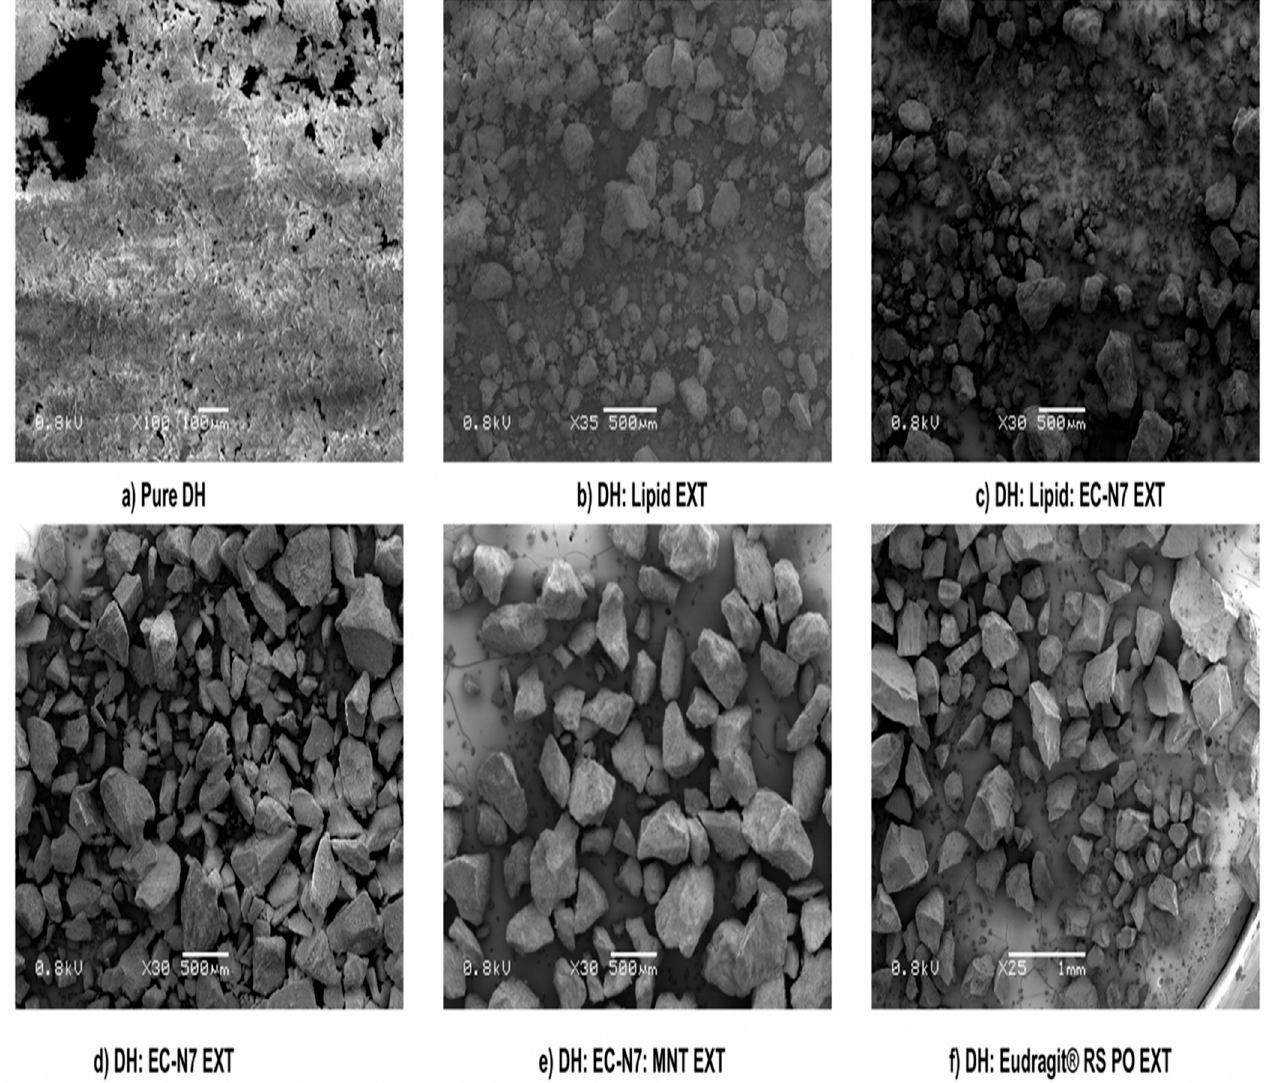
Figure 6. SEM of pure DH and screened extrudates.